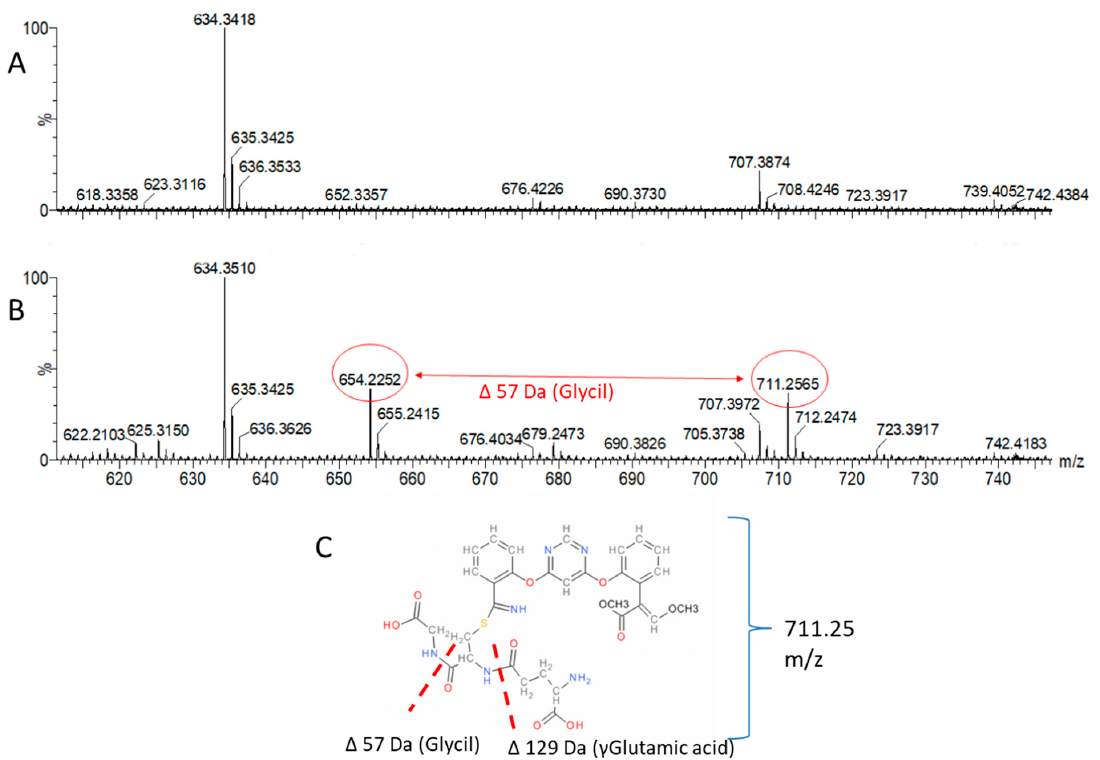
Figure 4. Neutral loss discovery of azoxystrobin-GSH conjugate at MS survey conditions of the precursor specie 711 m/z . Possible identification of potential azoxystrobin conjugate at RT 18.10–18.36 min. The analysis of MS survey profile for untreated (panel A ) and treated sample (panel B ) reveals that both 711.25 and 654.22 m/z species are present only in the treated sample. The glycil neutral loss (654.22 m/z ) is already occurring at +5eV low energy level (MS1 or MS survey). The azoxystrobin-glutathione conjugate (panel C ) at the cyano group has the MS/MS signature of azoxystrobin alongside the evidence of neutral loss of the glycil residue (neutral loss 57).